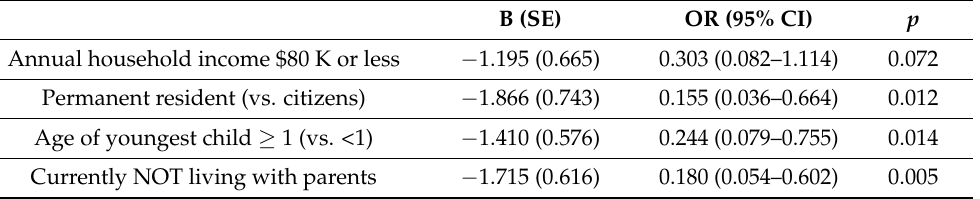
Table 5. Adjusted effects on Meeting PA Guidelines in the final model (N =